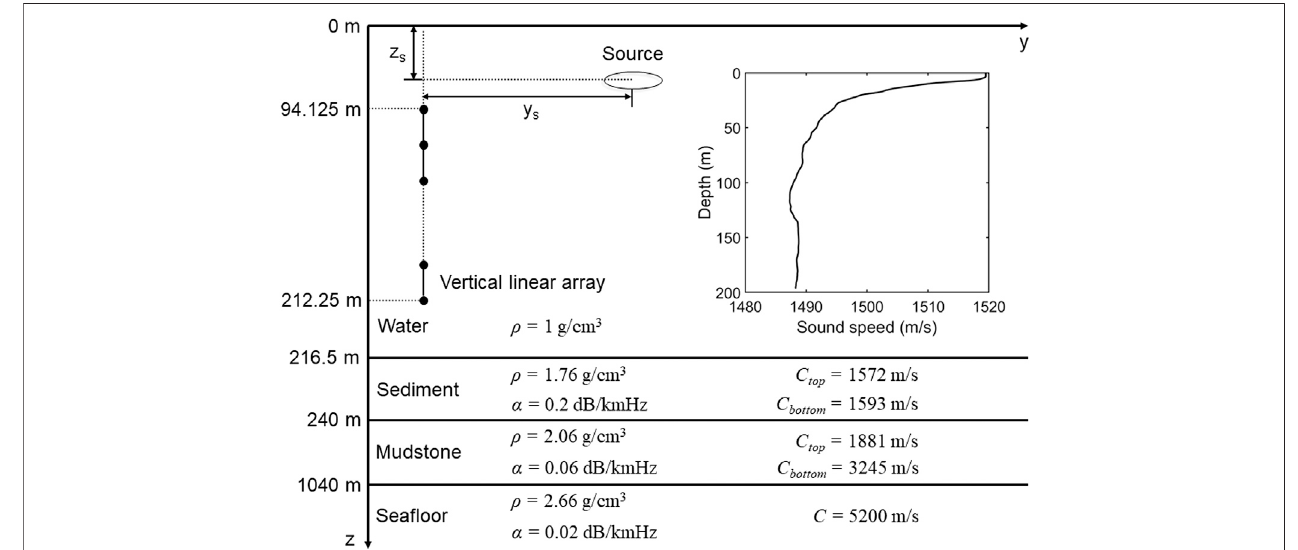
FIGURE 2 | Schematic diagram of the simulated acoustic environmental model.